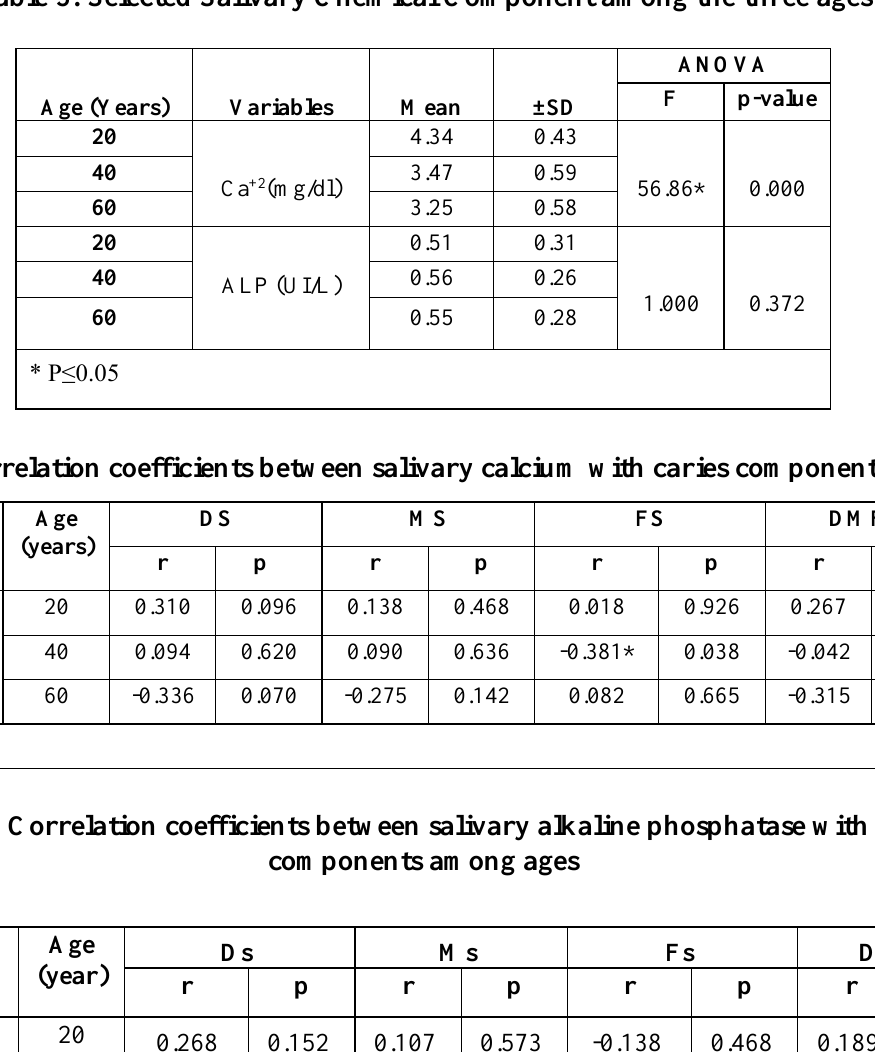
Table 5: Selected Salivary Chemical Component among the three ages